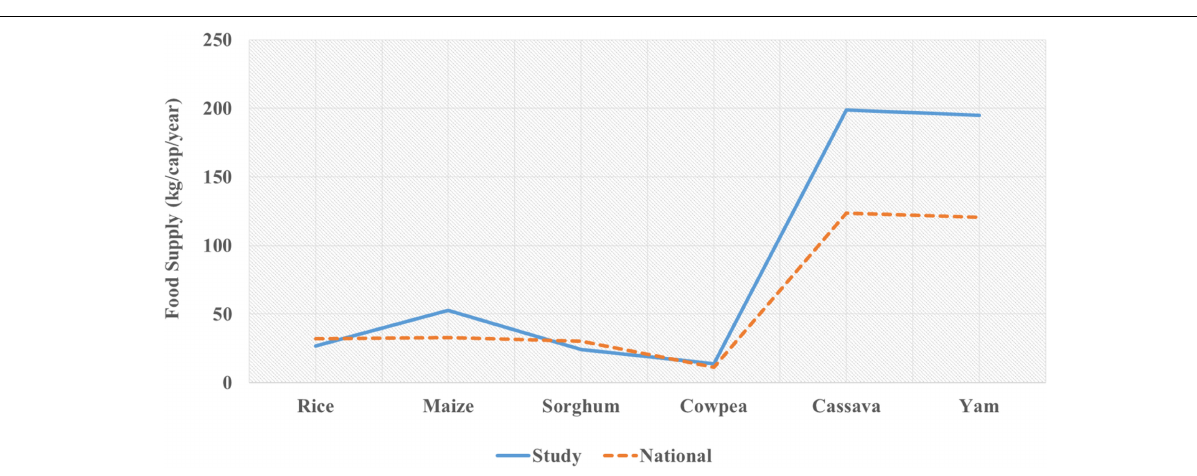
FIGURE 3 | Farmers food supply contribution to the food system in 2017 (FAOSTAT and